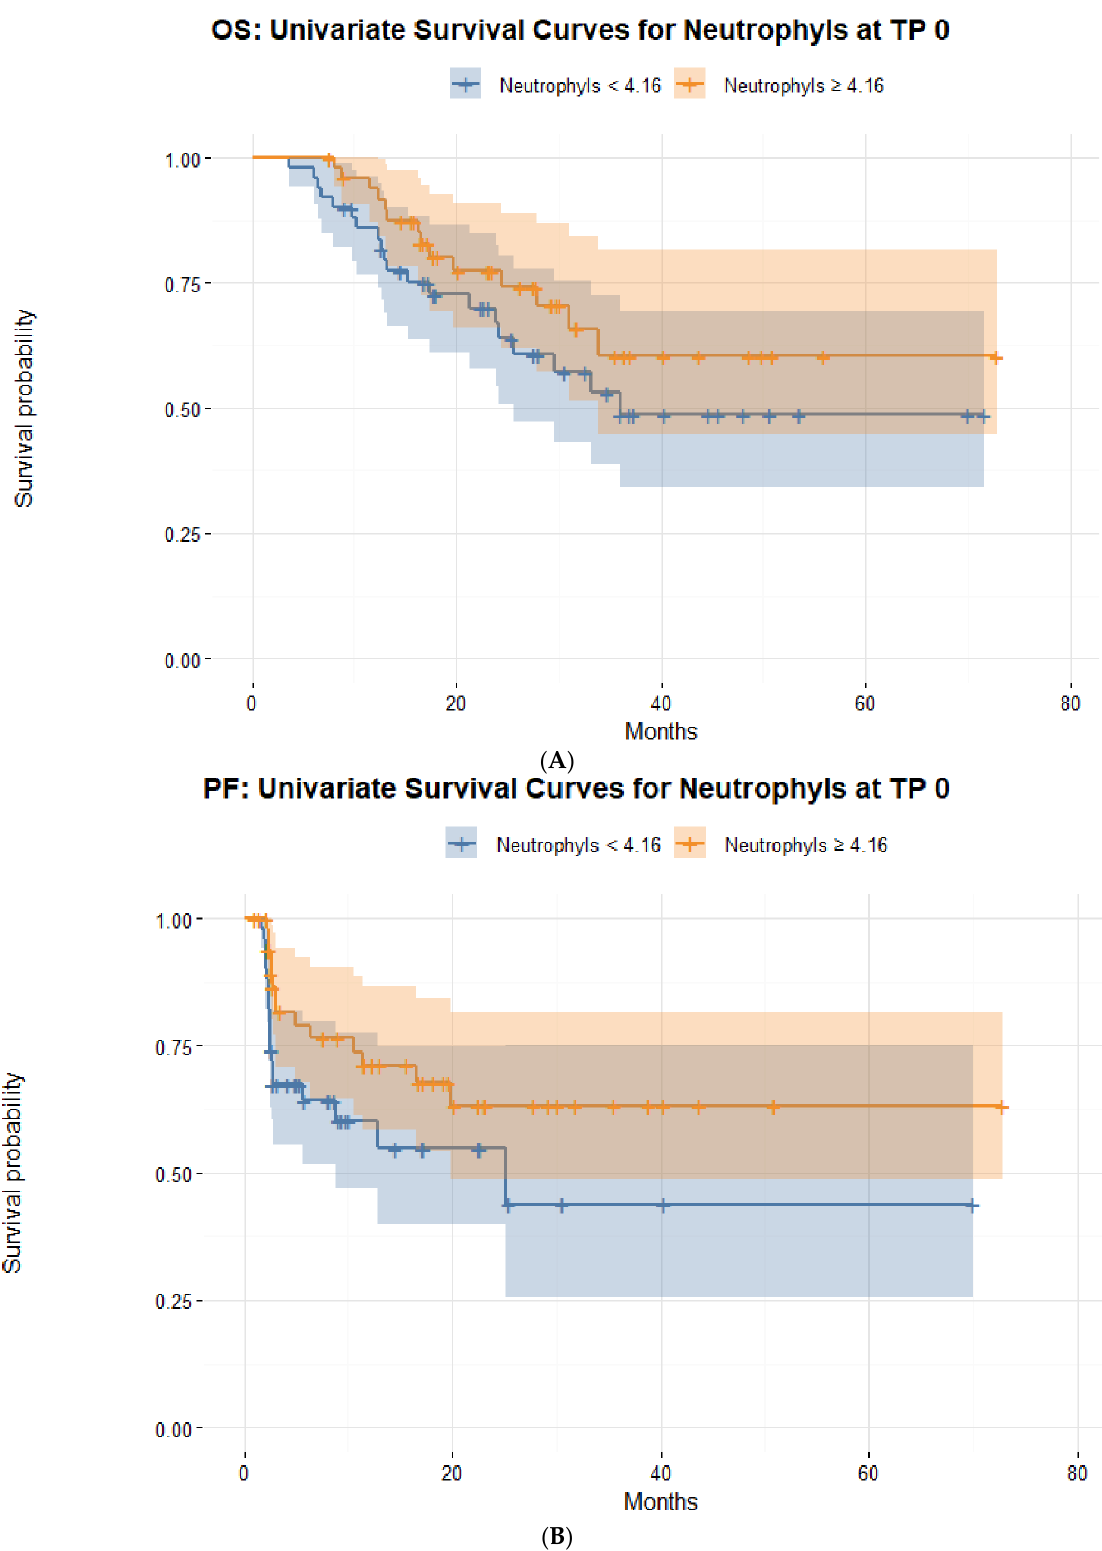
Figure 3. Kaplan–Meier survival curves stratified by the optimal cut-off count for neutrophils (g/L) at baseline in metastatic melanoma patients based on ( A ) overall survival and ( B ) progression-free survival.